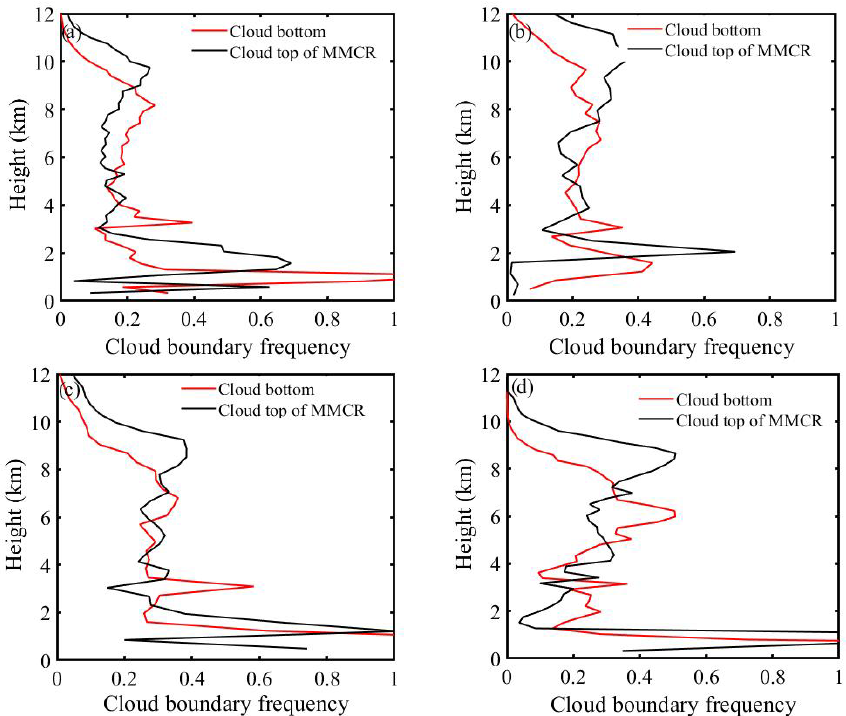
Figure 16. Frequency distribution of cloud boundaries during (a) spring, (b) summer, (c) autumn, and (d) winter from December 2020 to November 2021 at Xi’an Jinghe National Meteorological Station.